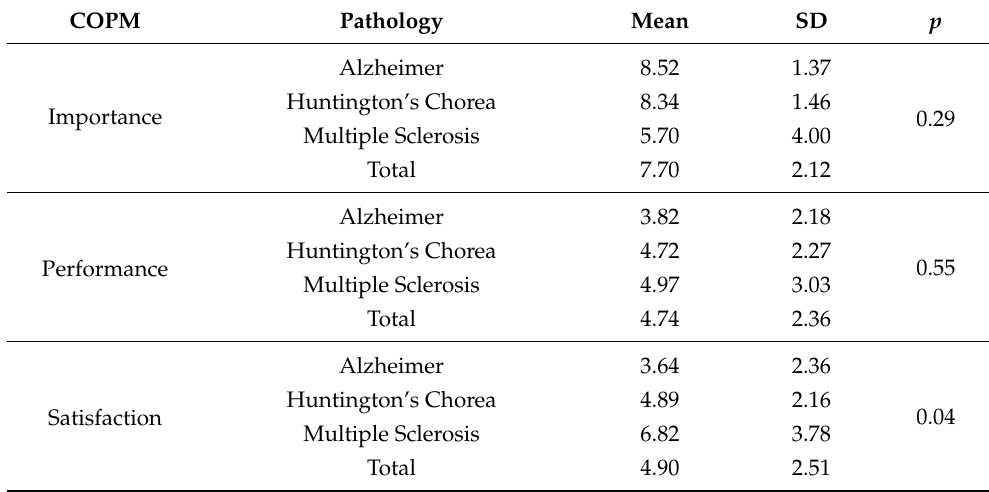
Table 1. Descriptive analyses on the COPM variables across pathology and the Kruskal–Wallis test.